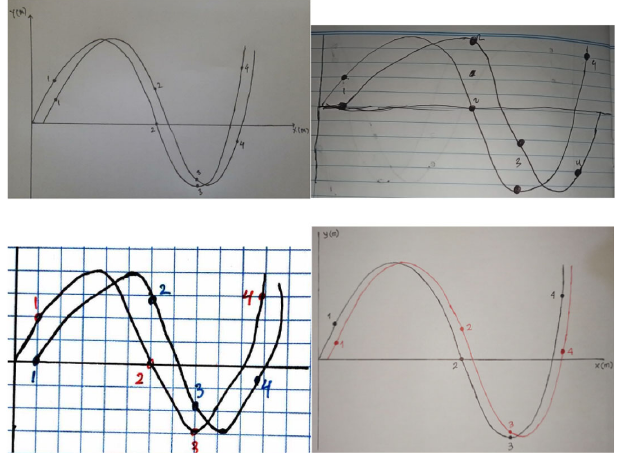
FIG. 14. Students ’ drawings after scaffolding level